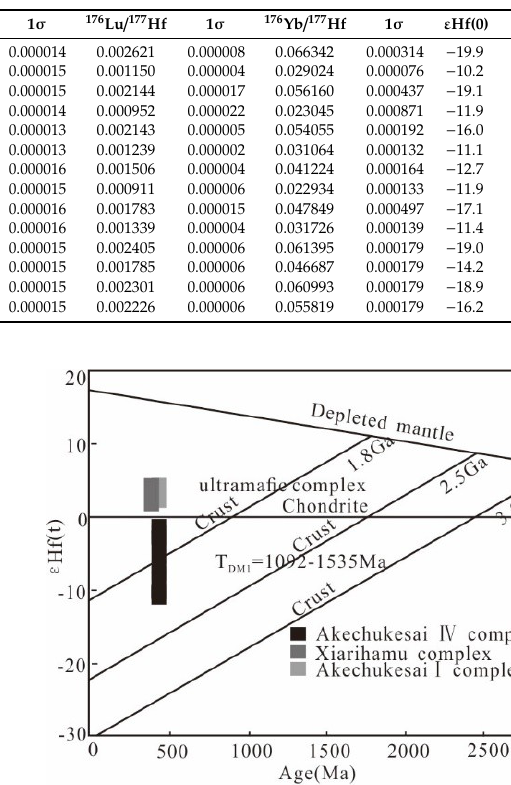
Figure 7. ε Hf (t) versus time (Ma) diagram for gabbro in Akechukesai IV mafic–ultramafic complex. Data sources for 1.8Ga, 2.5 Ga, and 3.0Ga lines are from Wu et al. [23]. Gray shadow areas are from Li et al. [6] and a compilation of literature data.